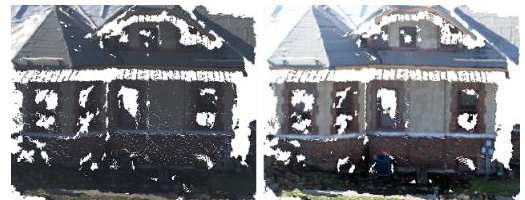
Figure 17. Point clouds of original (left) and manually edited images